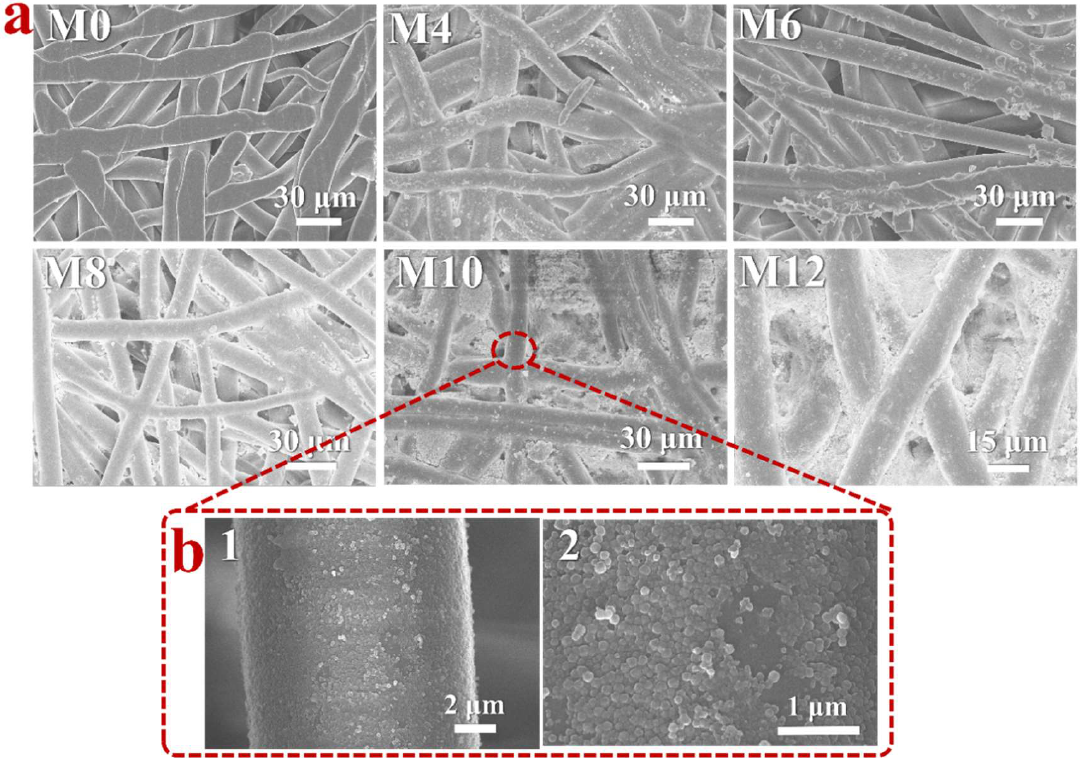
Figure 5. ( a ) SEM images of ZIF-8/PPS fiber membranes (M0: untreated; M4: 4 h; M8: 8 h; M10: 10 h; M12: 12 h); ( b ) SEM images of ZIF-8 attached to PPS fiber membranes (1: low magnification; 2: high magnification).